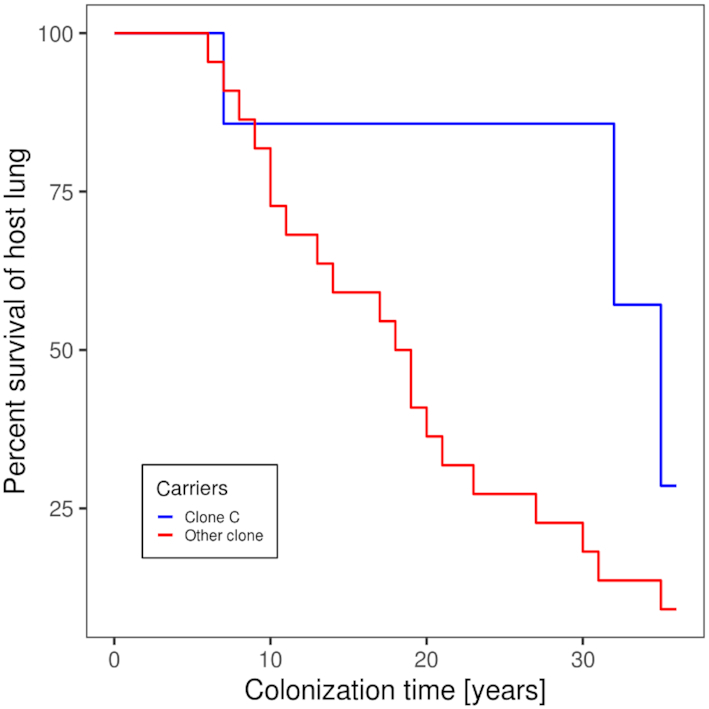
Duration of the chronic airway infection with P. aeruginosain individuals with cystic fibrosis carrying clone C (blue line) or any other clone (red line). The Kaplan–Meier plot shows individual length of colonization until lung transplantation or death because of respiratory insufficiency for the non-transplanted patients until June 1st, 2020. The data was extracted from the medical records of 29 CF patients regularly seen at the CF clinic Hannover who became chronically colonized with P. aeruginosa between 1984 and 1990.